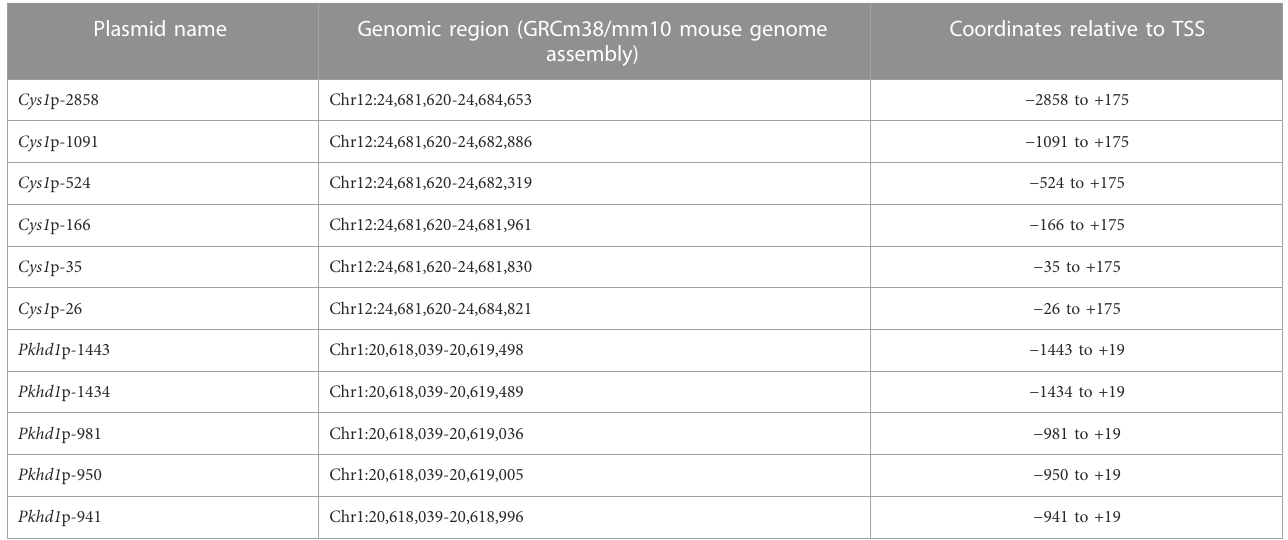
TABLE 2 Cys1 and Pkhd1 genomic DNA regions cloned into